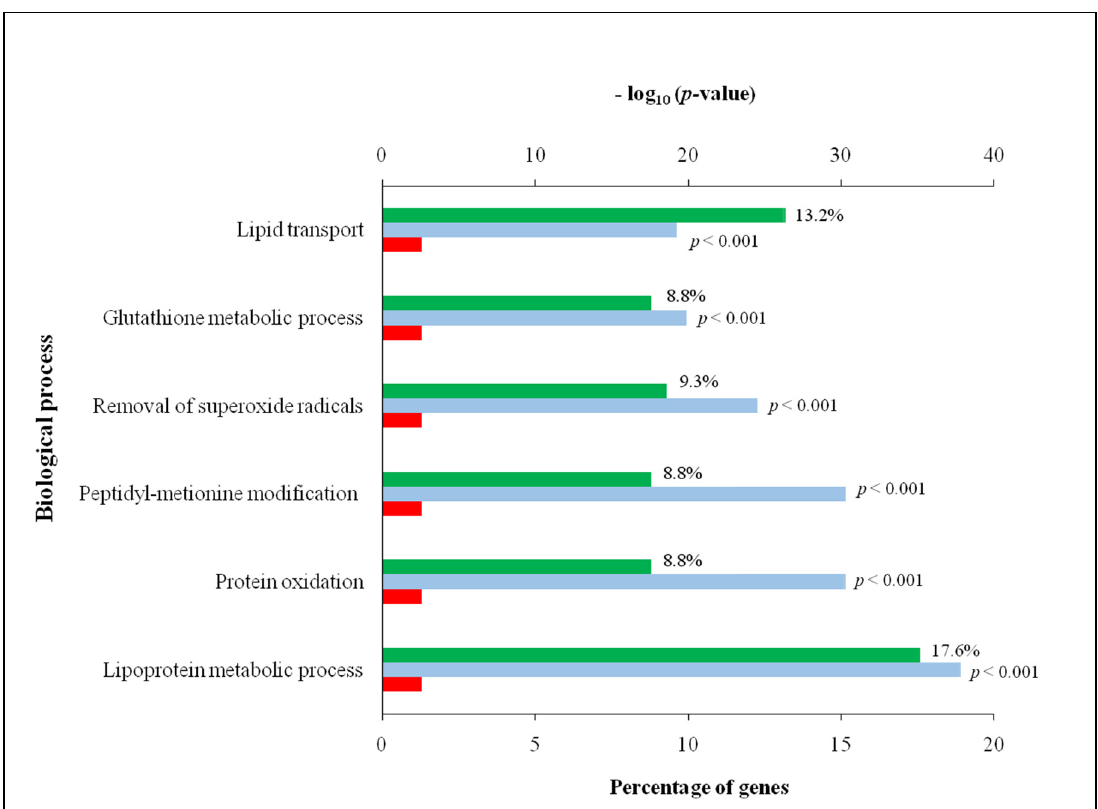
Figure 2. Functional enrichment analysis of differentially abundant proteins (expressed in percentage) of the antler samples of Iberian red deer ( Cervus elaphus ) of the two locations (tip and middle) using FunRich. The biological processes and molecular functions obtained were sorted by − log 10 ( p -value) and only the top 6 are displayed. The percentage of genes, p = 0.05 as reference and − log 10 ( p -value) are indicated in green, red and blue, respectively